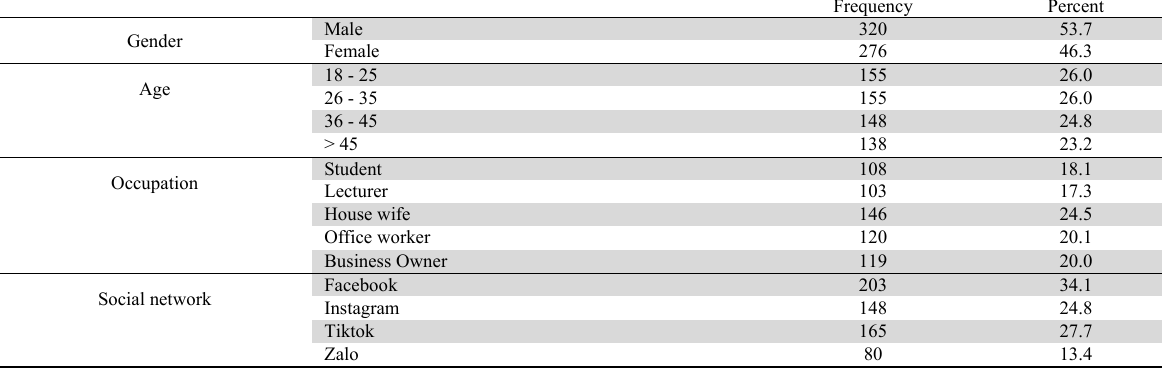
Demographic information